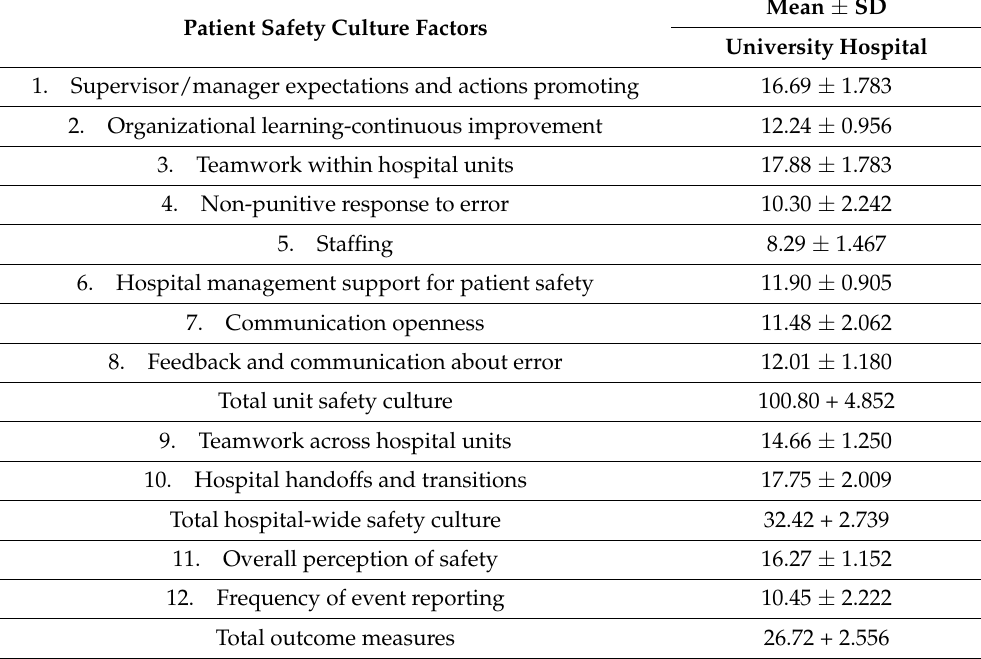
Table 3. Nurses’ Perception Regarding Patient Safety Culture Factors.